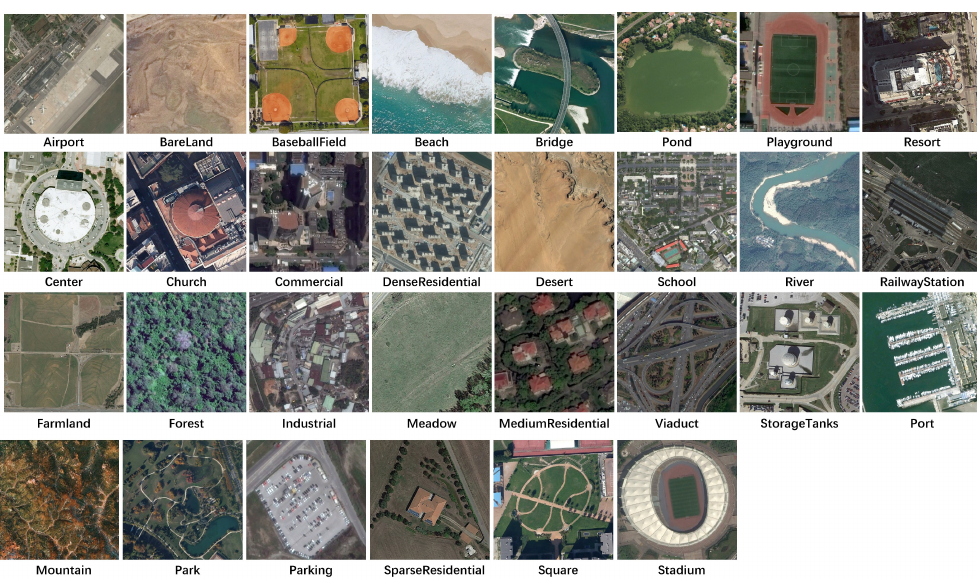
Figure 2. AID dataset. The AID dataset contains 30 classes of images, each class contains 200–400 images. Some of the images are shown in the figure.